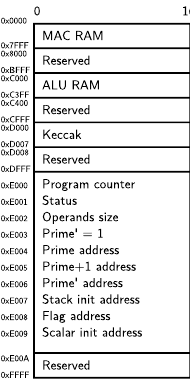
Figure 15: Memory arrangement of the SIKE